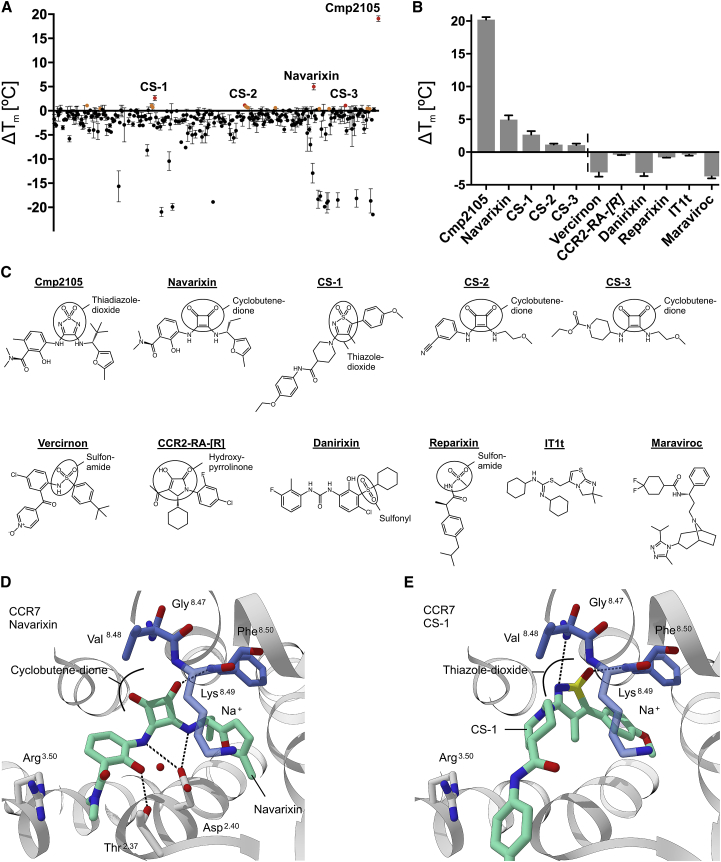
Focused Screening and Structural Diversity of Chemokine Receptor Ligands(A) 293 compounds were selected by virtual screening from Roche’s compound repository and tested experimentally for their ability to thermally stabilize CCR7. The graph plots the difference in thermal stability in presence of 50 μM ligand (black dots mean ± SEM from 3 determinations) to the DMSO control. Potentially stabilizing ligands are colored orange and hits above the combined standard deviation of DMSO and ligand are red.(B) To probe the selectivity of the binding pocket, we tested and analyzed a series of known chemokine receptor ligands and positive hits from virtual and semi-automated thermofluor screening (mean ± SEM from 3 measurements) (Mattle et al., 2018). The dashed vertical line divides measurements from the automated thermofluor assay and separate measurements with selected ligands.(C) Selection of allosteric small molecule ligands against chemokine receptors tested for their effect on CCR7. The central core motif binding the TM7-H8 motif is highlighted.(D and E) Docking of Navarixin and CS-1 into the allosteric CCR7 binding pocket. The TM7-H8 joint is shown in blue and selected key residues are drawn as sticks.